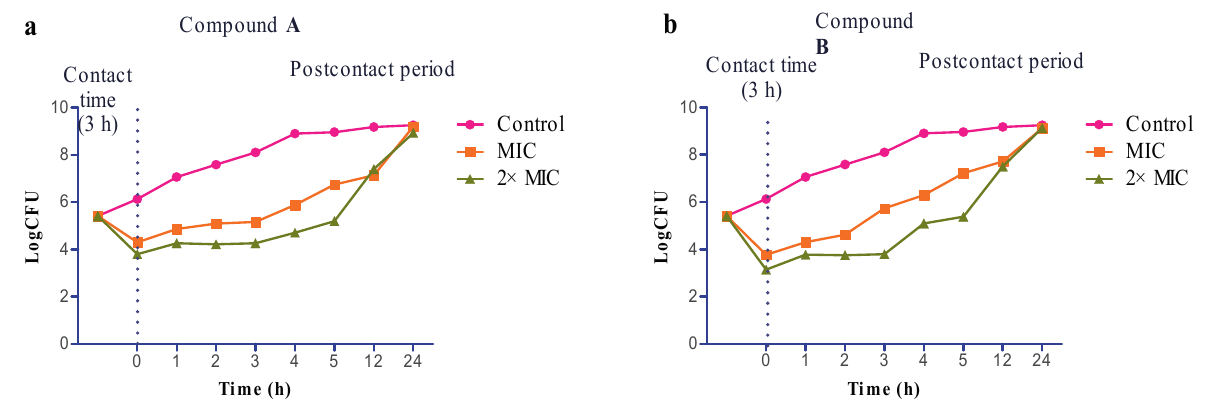
Figure 3. Evaluation of postcontact effect (PCE). The PCE of compound A ( a ), compound B ( b ) on S. aureus growth. All experiments were performed in